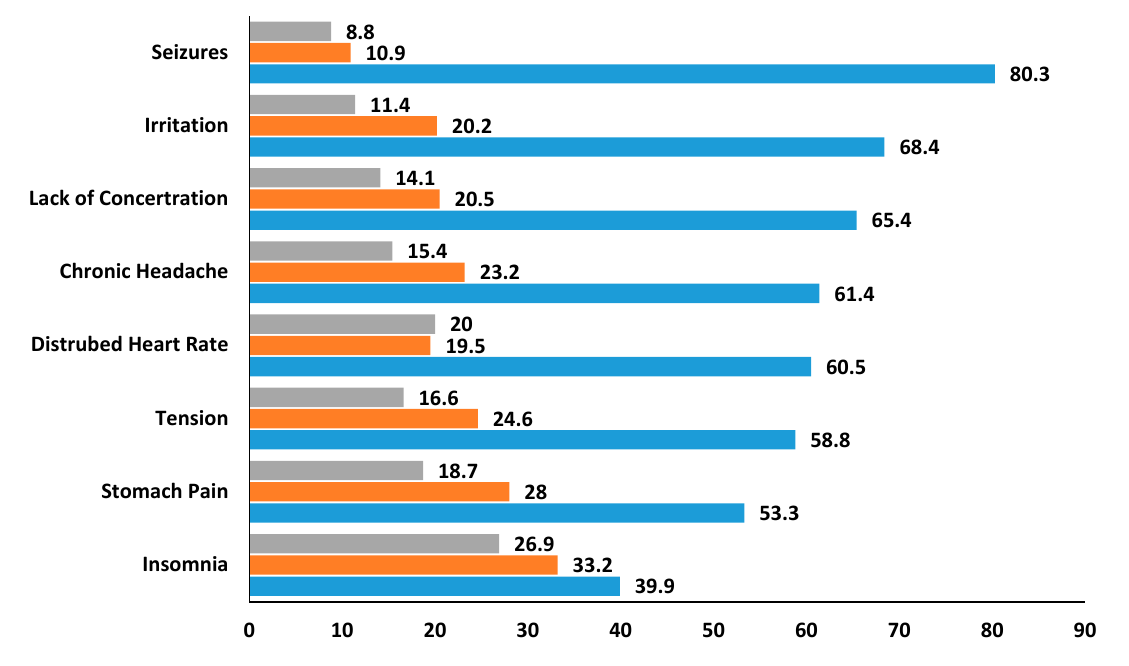
Figure 1. The frequency of symptoms related to coffee consumption.